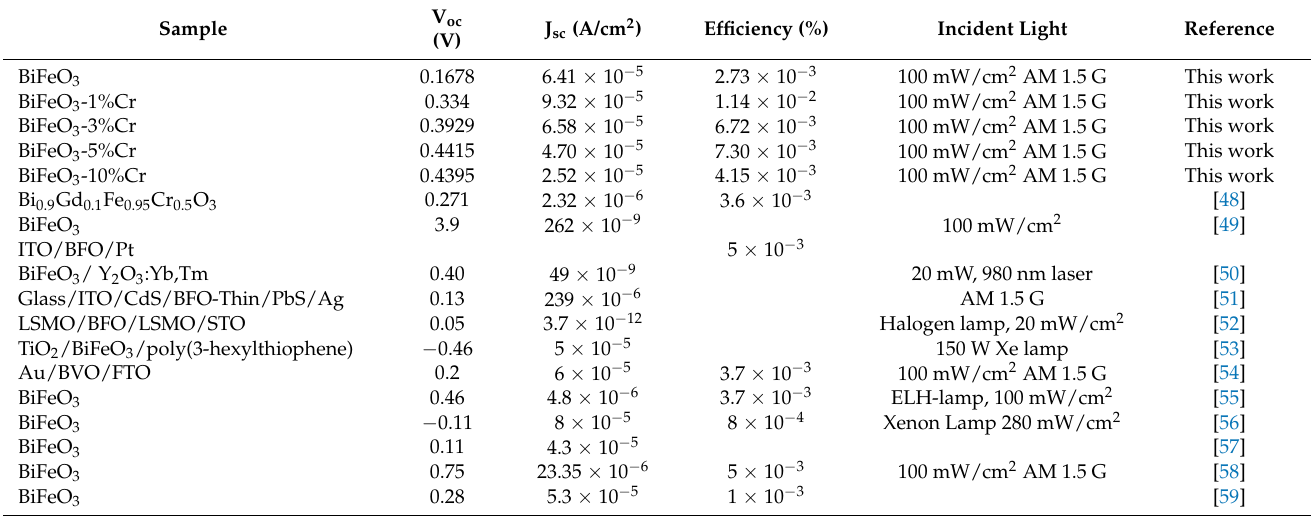
Figure 6. Current density-voltage curves for pure and Cr-doped BiFeO 3 . Table 3. Photovoltaic parameters of pure and Cr-doped BiFeO3 solar cells compared with works reported in the literature.